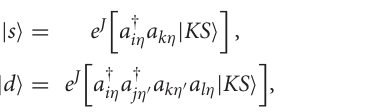
2 cell with U d / t pd 8, × =